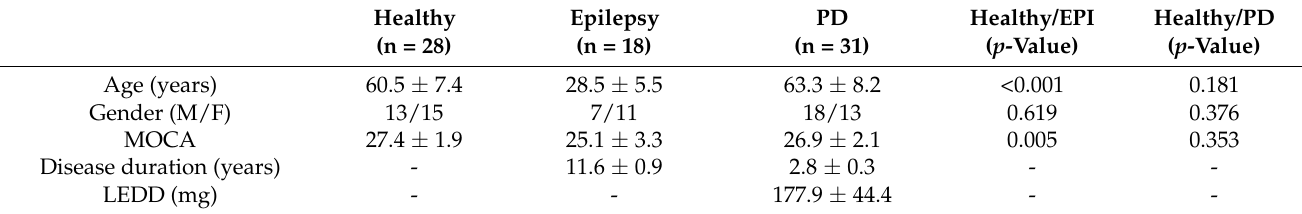
Table 1. Participants’ characteristics.